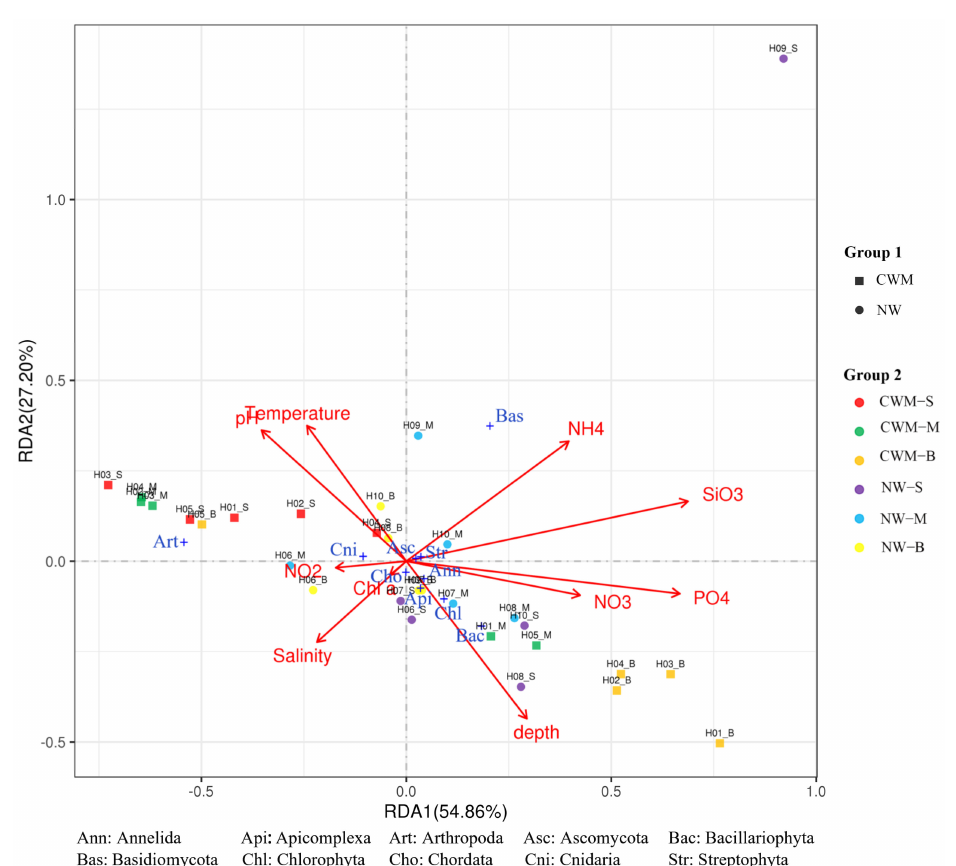
Figure 8. Redundancy analysis (RDA) of eukaryotic plankton community structure associated with